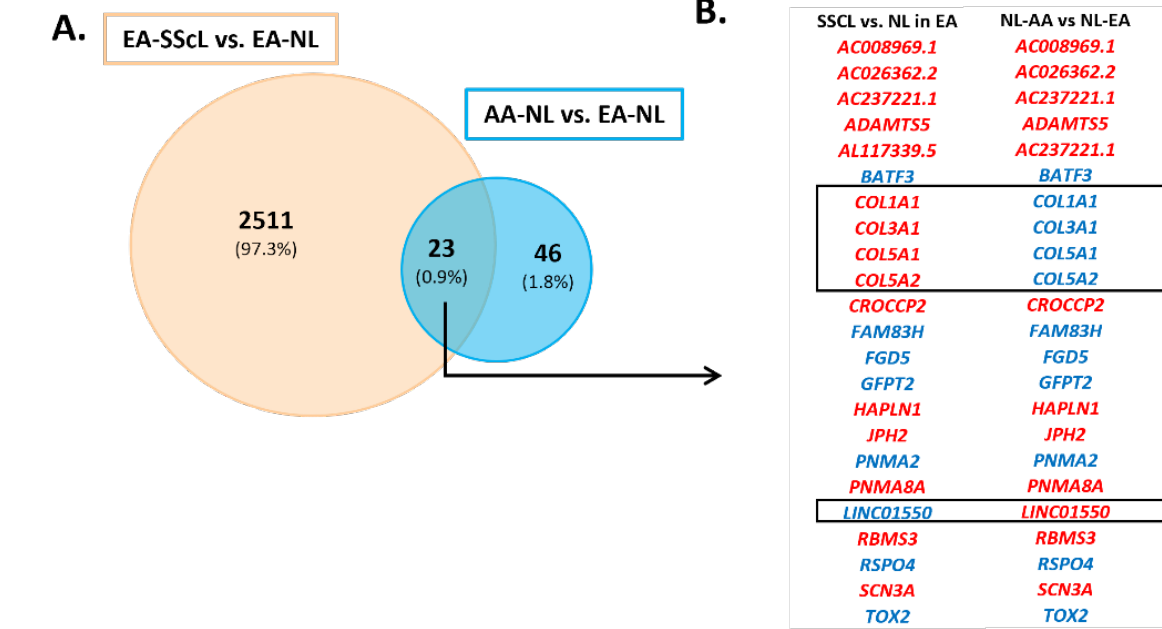
Figure 4. Functional enrichment of the DEGs unique to AA-SScL fibroblasts. ( A ) Venn diagram comparing the DEGs from the comparison “EA-SScL vs. EA-NL” to the DEGs obtained from the comparison “AA-NL vs. EA-NL.” At the intersect, 23 DEGs are commonly deregulated in AA-NL and EA-SScL fibroblasts, out of which 18 are deregulated in the same direction ( B ). Red: upregulated DEGs, blue: downregulated DEGs. The boxes in panel B show the DEGs at the intersect of the Venn diagram in panel A that are oppositely deregulated: COL1A1, COL3A1, COL5A1, COL5A2, LINC01550 . 2.3. AA-SScL vs. EA-SScL: What Are the Differences in Disease State? The SScL fibroblasts in this study were cultured from the explanted lungs of SSc pa- tients with advanced PF who underwent transplantation. We compared the transcriptome of SSc-PF in AA and EA patients. The DE analysis AA-SScL vs. EA-SScL returned 384 DEGs, including 109 upregulated and 275 downregulated genes (Figure S1E, DE analysis #4). The PCA plot (Figure 5A) showed poor clustering of the AA and EA SScL samples. However, two main clusters were defined on the heatmap (Figure 5B). Cluster 1 contained four EA samples (SSc19, SSc27, SSc30, SSc23) with fibrosis (FVC < 70%) and no pulmonary hyper- tension (PH), barring SSc19 with mild PH (pulmonary artery pressure mean = 26 mm Hg) (Figure S2, Table S3). Cluster 2 was divided into two subclusters: 2a and 2b. Subcluster 2a consisted of one AA sample (SSc15) and two EA samples (SSc25, SSc38) from patients who had extensive pulmonary fibrosis (FVC < 70%) without evidence of PH. The transcriptomic signatures of these samples were less defined than cluster 1 and subcluster 2b. Subcluster 2b contained five AA samples (SSc46, SSc59, SSc18, SSc77, SSc85) from patients who had both pulmonary fibrosis and PH (FVC ranging from 18 − 46%, and PA mean >25 mm Hg), except for SSc18 who just had pulmonary fibrosis. Their transcriptomic signatures were markedly distinct from cluster 1. The perturbation versus over-representation pathway analysis showed that the most significant pathways in AA-SScL fibroblasts were “Calcium signaling,” “Regulation of actin Cytoskeleton,” “Gap junction,” “Prostate cancer,” “Choline metabolism in cancer,” “Melanoma,” “Taste transduction,” “Intestinal immune network of IgA production,” “Alco- holism,” and “Steroid biosynthesis” (Figure